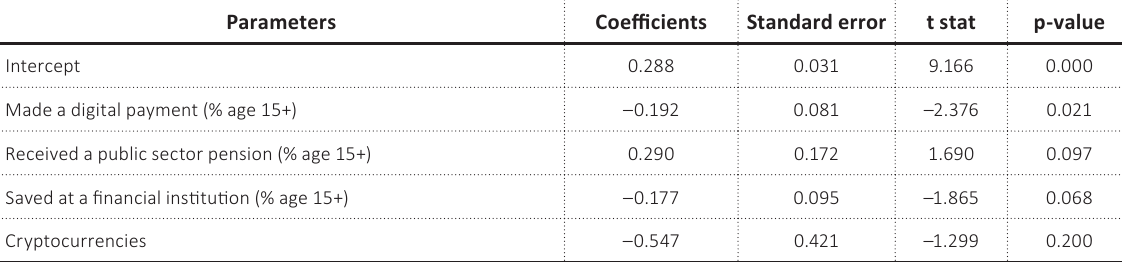
Table 2. Regression